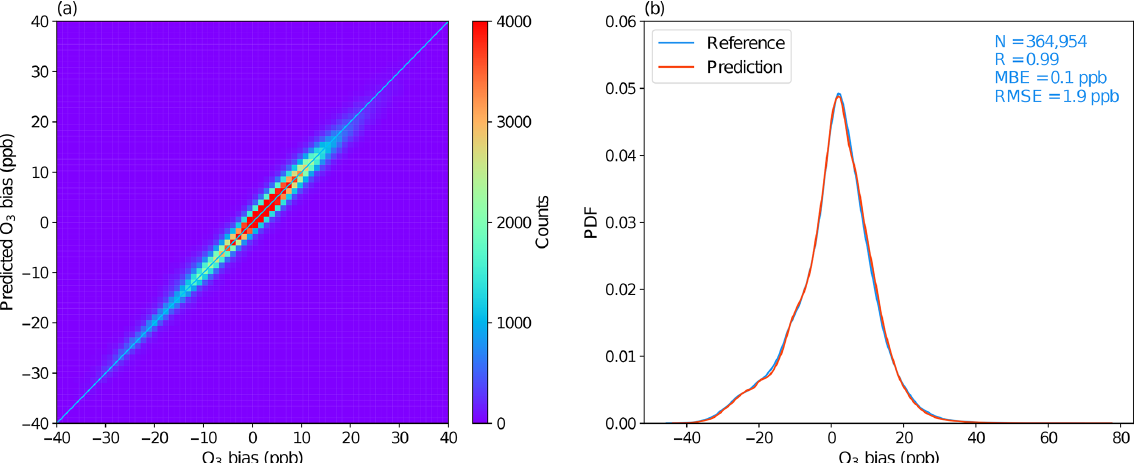
Figure 3. Evaluation of the deep learning model in simulating monthly mean surface O 3 biases at each UKESM1 grid point based on testing data. (a) O 3 biases (UKESM1 minus CAMS) and biases predicted by the deep learning model. (b) Probability density function of O 3 biases (labelled here as Reference) and predicted O 3 biases. Statistics are shown in the top right